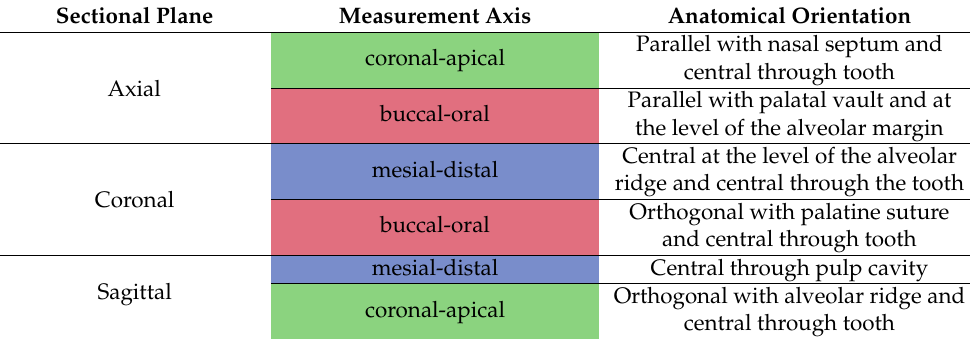
Table 1. Overview of sectional planes and measurement axes.